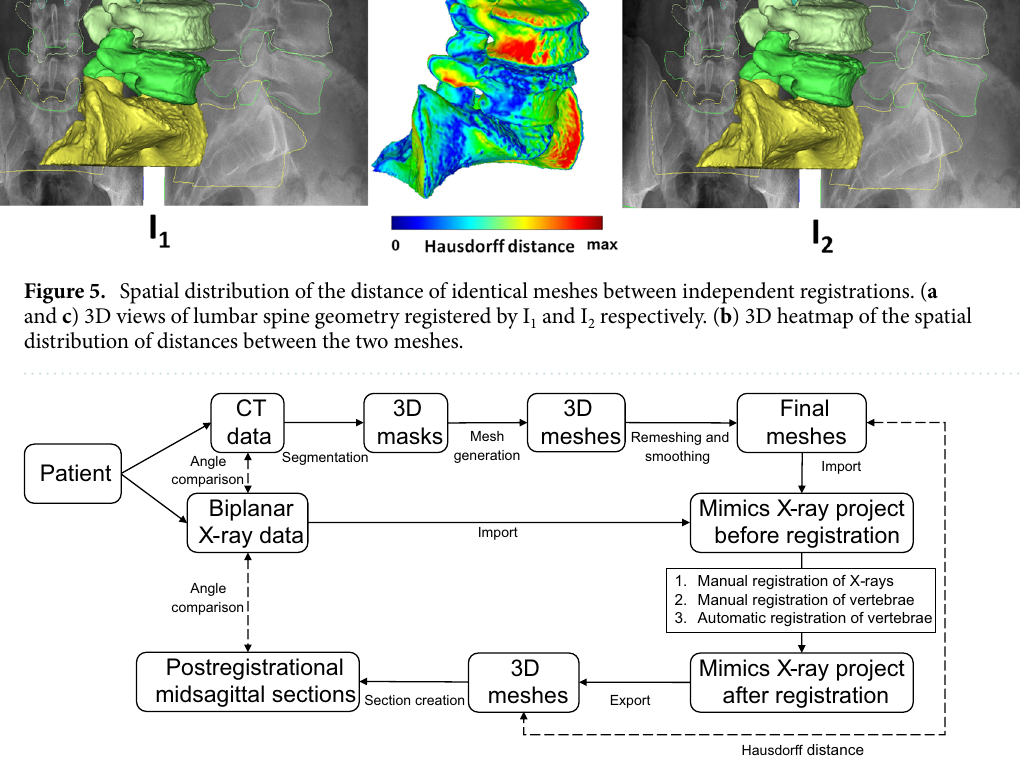
Figure 6. Flowchart of the used methods, with measurements denoted as dashed double-headed